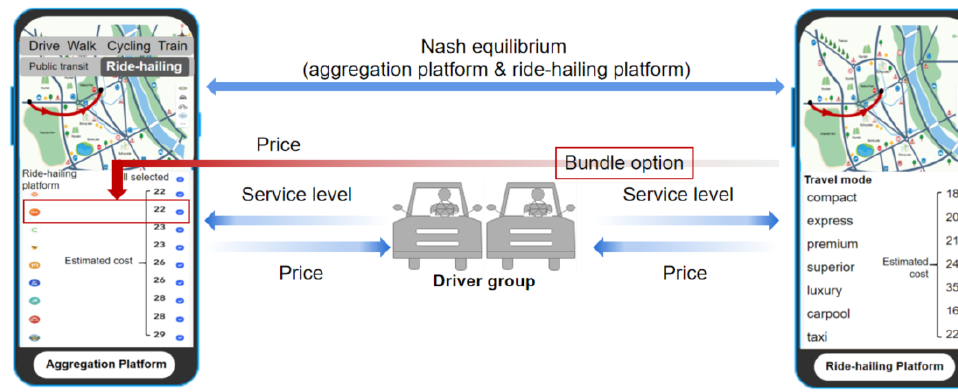
Figure 5. Structure of Model B.